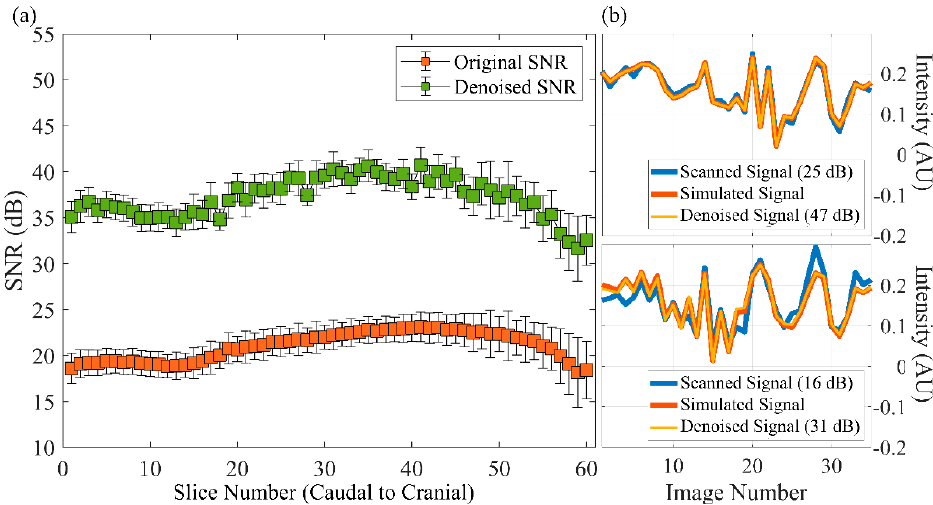
Figure 4. Signal-to-noise ratio (SNR) before and after denoising. ( a ) Plot of the mean (solid color box) and standard deviation (thin line bar) of the SNR in slices of the whole brain. ( b ) Two examples of the signal before and after denoising were gathered from one pixel in slice 35 (top) and slice 13 (bottom). Table 1. SNR before and after the denoising model.